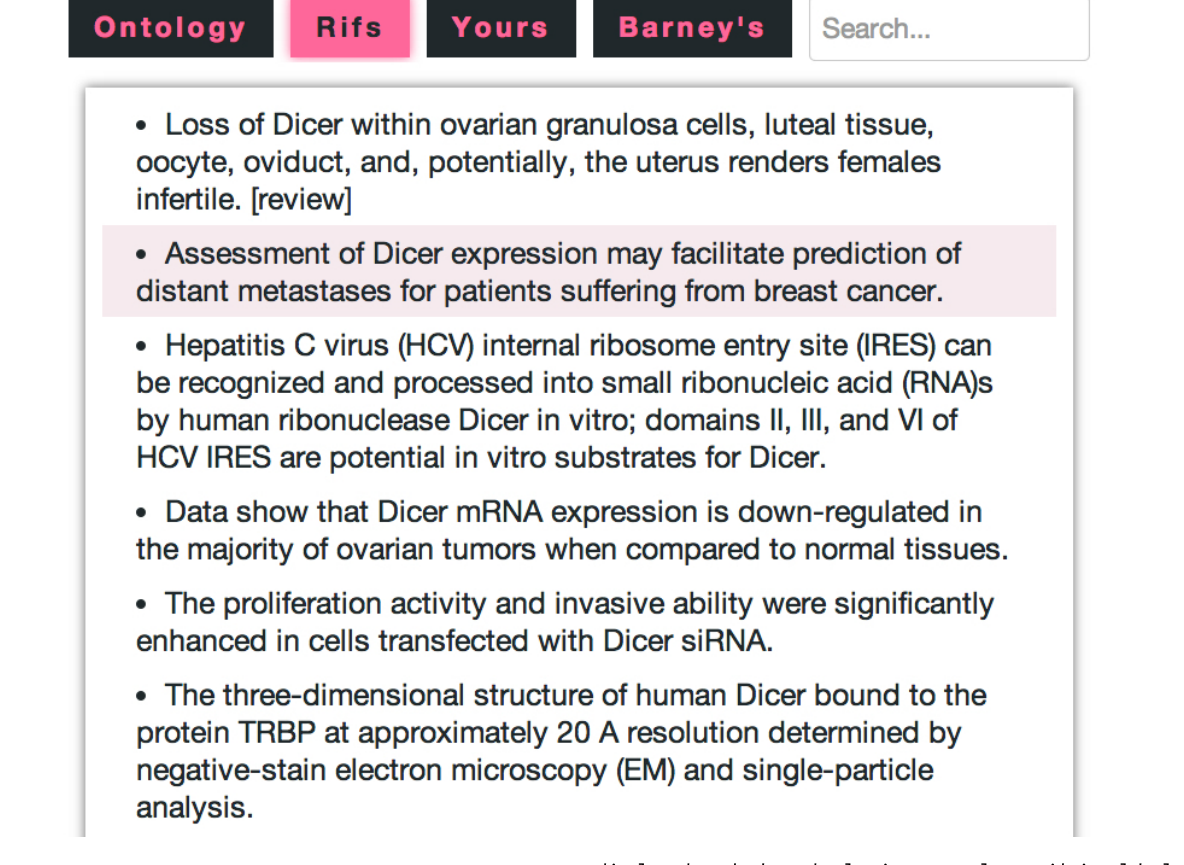
Figure 2. The Gene Rifs tab showing information about the Dicer gene. Gene Rifs provide textual descriptions of gene function extracted from abstracts. These can be used to gain insights into the possible connections between the gene and breast cancer prognosis, and thus can help players to intelligently select genes in the